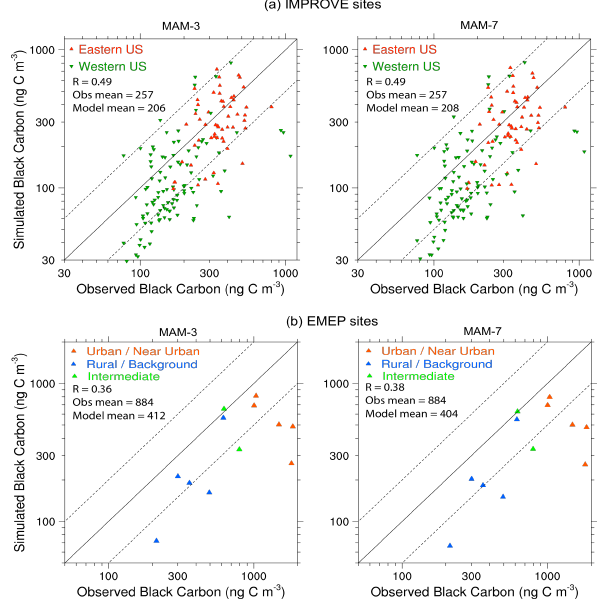
Figure 11. Observed and simulated annual-average black carbon (BC) concentrations (ng Fig. 11. Observed and simulated annual-average black carbon (BC) C m -3 ) at IMPROVE and EMEP BC/OC network sites. Observations are for site- concentrations (ngCm − 3 ) at IMPROVE and EMEP BC/OC net- available years between 1995-2005 for IMPROVE sites and July 2002 – June 2003 for EMEP sites. Simulated values for MAM3 (left) and MAM7 (right) are from model work sites. Observations are for site-available years between 1995– lowest layer. Top: IMPROVE network, Eastern U.S. sites are east of 97 W longitude. 2005 for IMPROVE sites and July 2002–June 2003 for EMEP sites. Bottom: EMEP network. Simulated values for MAM3 (left) and MAM7 (right) are from model lowest layer. Top: IMPROVE network; Eastern US sites are east of 97 ◦ W longitude. Bottom: EMEP